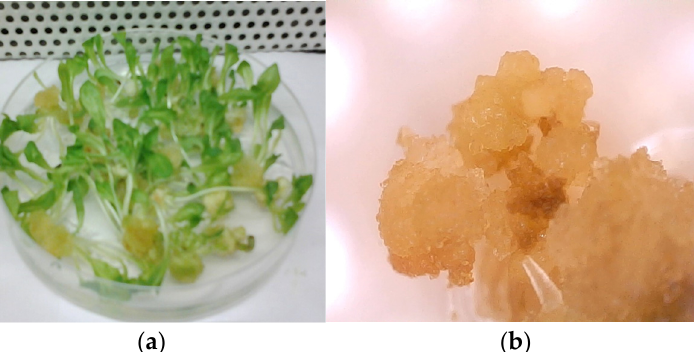
Figure 2. Callus induction from hypocotyls. ( a ) Callus derived from hypocotyl explants under light conditions (16/8 light/dark); ( b ) callus derived from hypocotyls grown under dark conditions (0/24 light/dark) (medium MS supplemented with sucrose 2.3%, 0.1 mg/L of NAA, and 2.0 mg/L of BAP and maintained under light condition at 18 ± 2 °C, two weeks after induction). Table 3. Developmental and morphological parameters of T. officinale callus derived from hypocotyls two weeks after induction under different carbon source types (sucrose and glucose) and concentrations (1.0%, 2.3%, 3.2%, and 5.5%) (medium MS supplemented with 0.1 mg/L of NAA and 2.0 mg/L of BAP, at 18 ± 2 ◦ C and 0/24 h light/dark). Carbon Source Type and